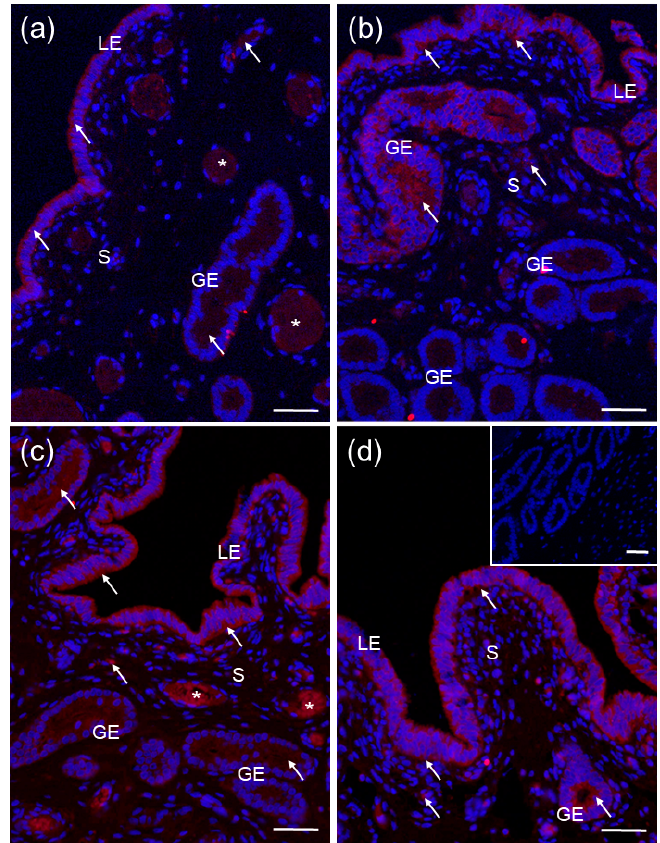
Figure 5. Representative micrographs of CYP24A1 immunofluorescent localization within porcine uterus on days 2–5 ( a ), 10–12 ( b ), 15–16 ( c ) and 18–20 ( d ) of the estrous cycle. Immunoreactive proteins were visualized using a Cy3 detection system (red). Nuclei were counterstained with DAPI (blue). Positive signal ( arrows ) was only found in the cytoplasm of luminal (LE) and glandular (GE) epithelial cells of the endometrium. Negative control ( d inset) was obtained by the replacement of primary antibody by non–immune rabbit IgG. S, stroma; asterisks (*), blood vessels. Bar = 50 µm.